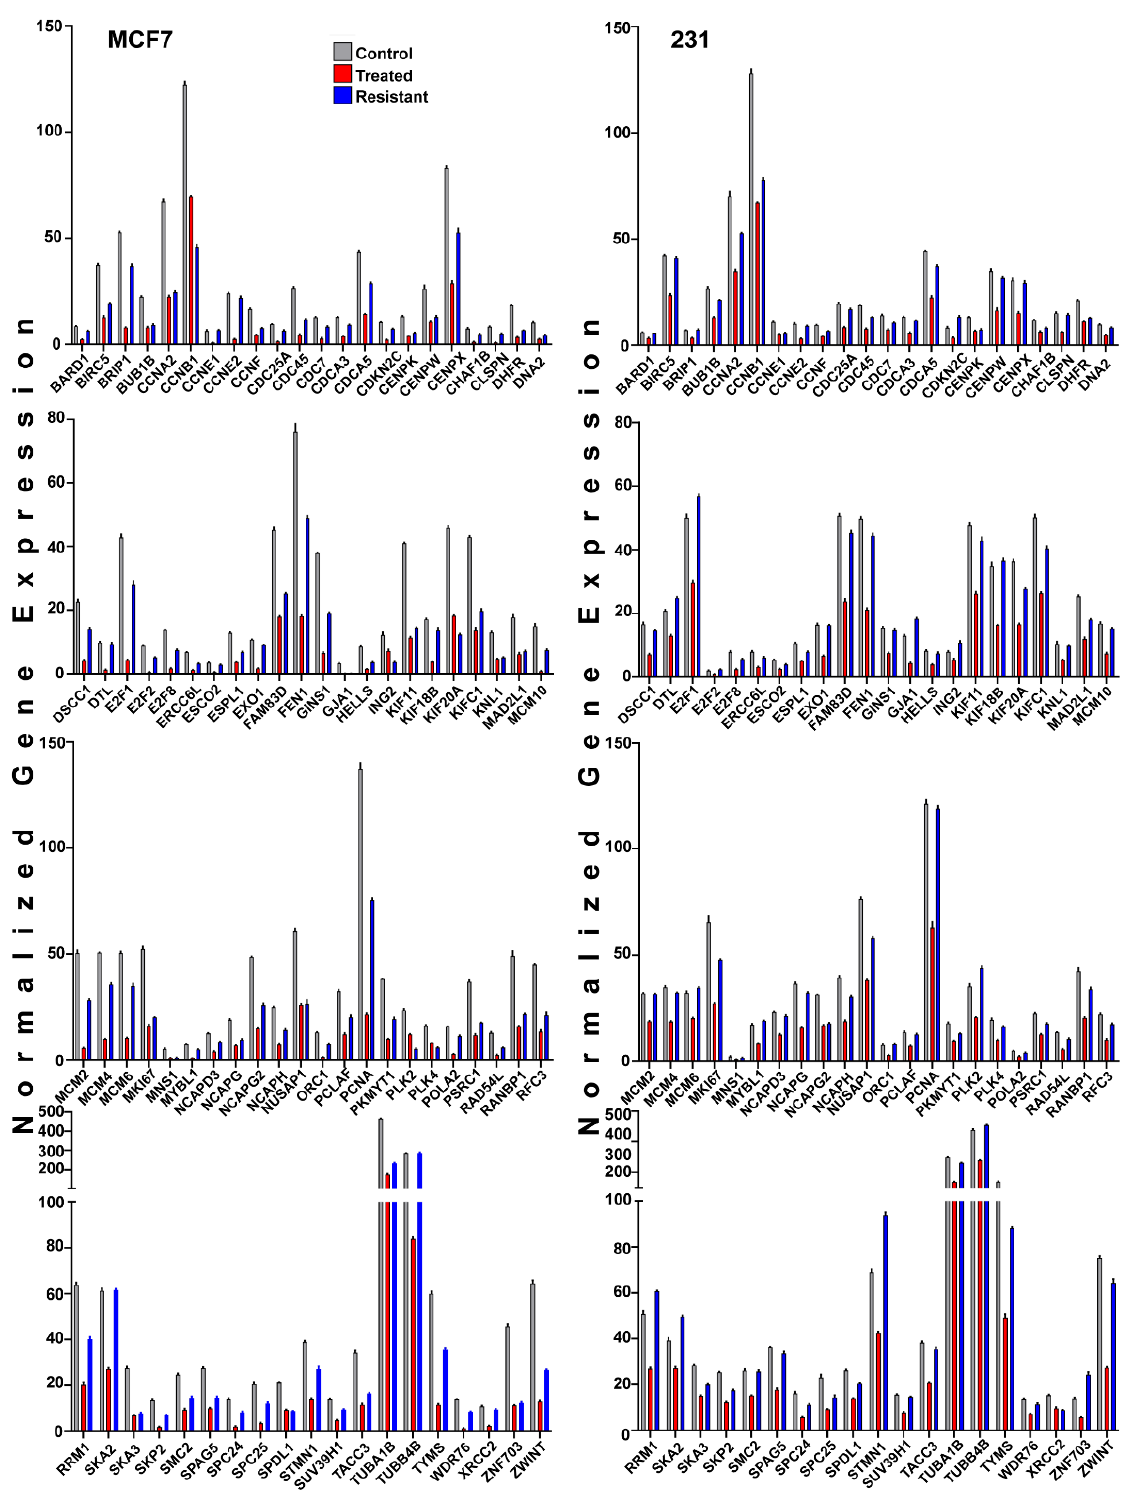
Figure 7. Comparison of the expression of 85 cell cycle related genes in MCF7 and 231 cells with FOXM1 inhibitor sensitivity or resistance. Gene expression in control parental (grey), short-term 24 h treated (red), and resistant (blue) cells is shown. Genes are arranged alphabetically and represent those in the iDEP cell cycle gene category. Each bar is the mean from three separate assays. Error bars were less than 10% of the mean and are not shown for clarity. Trends overall show reduced gene expression in short-term (24 h) treated cells (red) and their reversal with increased expression back toward control parental (grey) level of expression in NB73 resistant (blue) cells. Gene-wise statistical analysis for each of the 85 cell cycle related genes in MCF7 and in 231 parental, short-term treated, and resistant cells is presented in Supplementary Table S6.